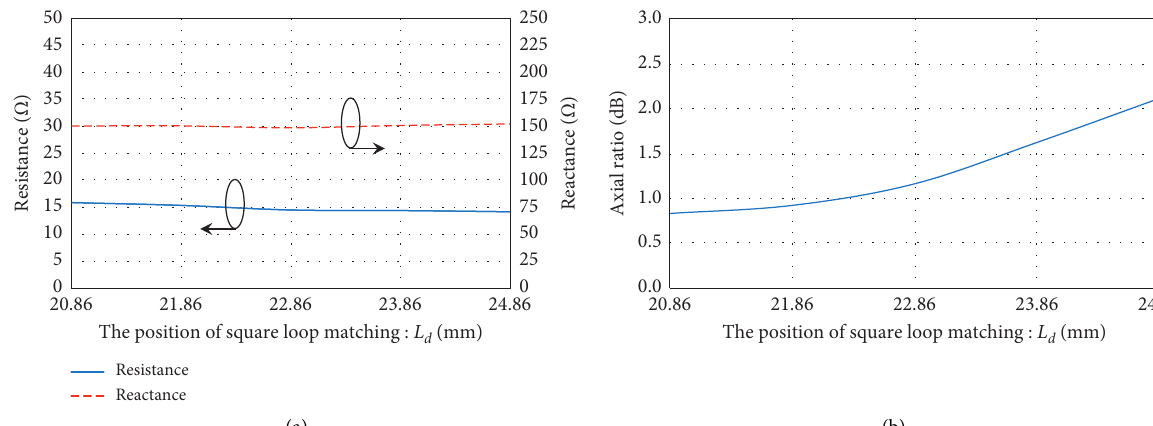
(b) d : (a) impedance and (b) axial wound) are used as the transmitting antennas with left- handed and right-handed CP radiation. The designed UHF- RFID tag antenna under test radiating left-handed CP acted as receiving antenna. The received power was measured from each case of transmitting antenna. The corresponding co-polarized and cross-polarized electric fields are,